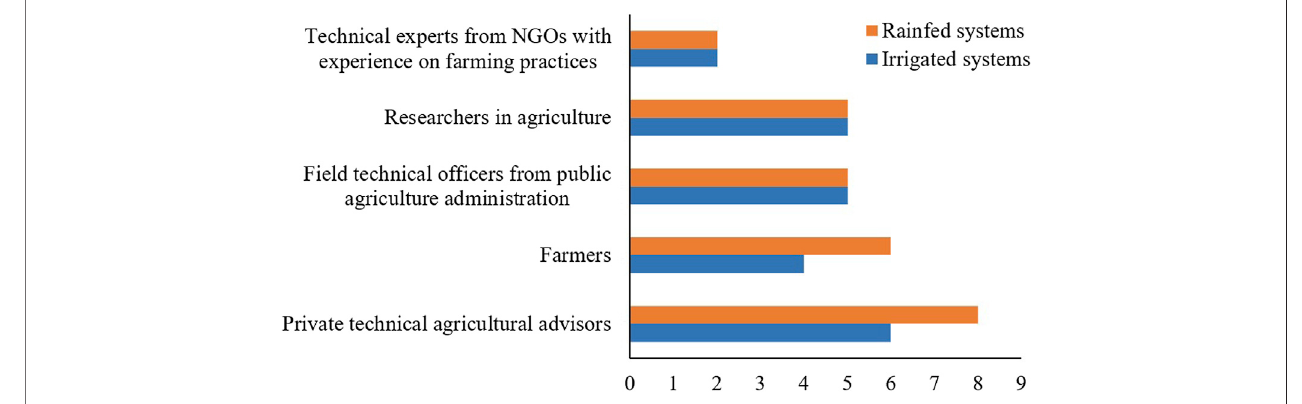
FIGURE 2 | Number of respondents grouped per type of stakeholders for both rainfed and irrigated cereal-based cropping systems.